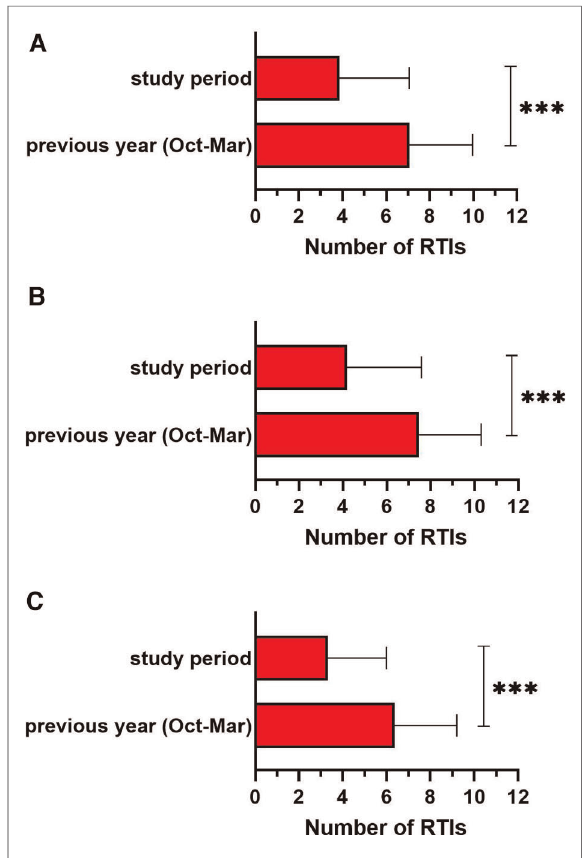
FIGURE 1 The total number of respiratory tract infections (RTIs) in the study period compared to the same period of the previous year (october – march) in ( A ) all children ( n =994), ( B ) in children under 4 years old ( n =609) and ( C ) in children over 4 years old ( n =385). *** p <0.001.